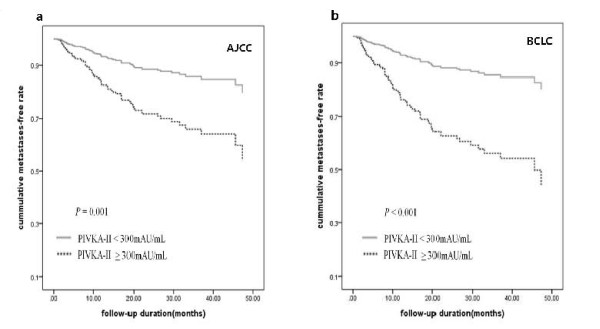
The median time to extrahepatic metastases in patients with a PIVKA-II ≥ 300 mAU/mL. The cumulative metastasis-free rate was analyzed in a multivariate Cox regression model in patients with a PIVKA-II ≥ 300 in AJCC (1a; Hazard Ratio, HR = 2.7, 95% confidence interval [CI] = 1.535-4.812, adjusted P = 0.001) and BCLC stage BCLC (1b: HR = 3.7, 95% CI = 2.073-6.560, adjusted P < 0.001) adjusting for such covariates as platelet count, AFP ≥ 400, portal vein thrombosis, and stage.